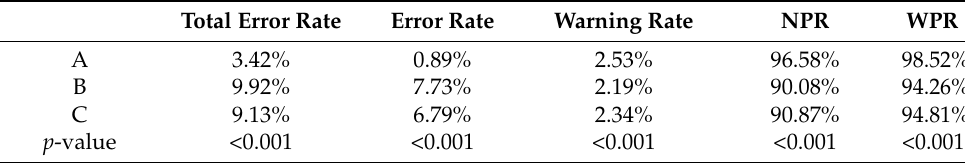
Table 4. Multicenter OMOP CDM data quality summary